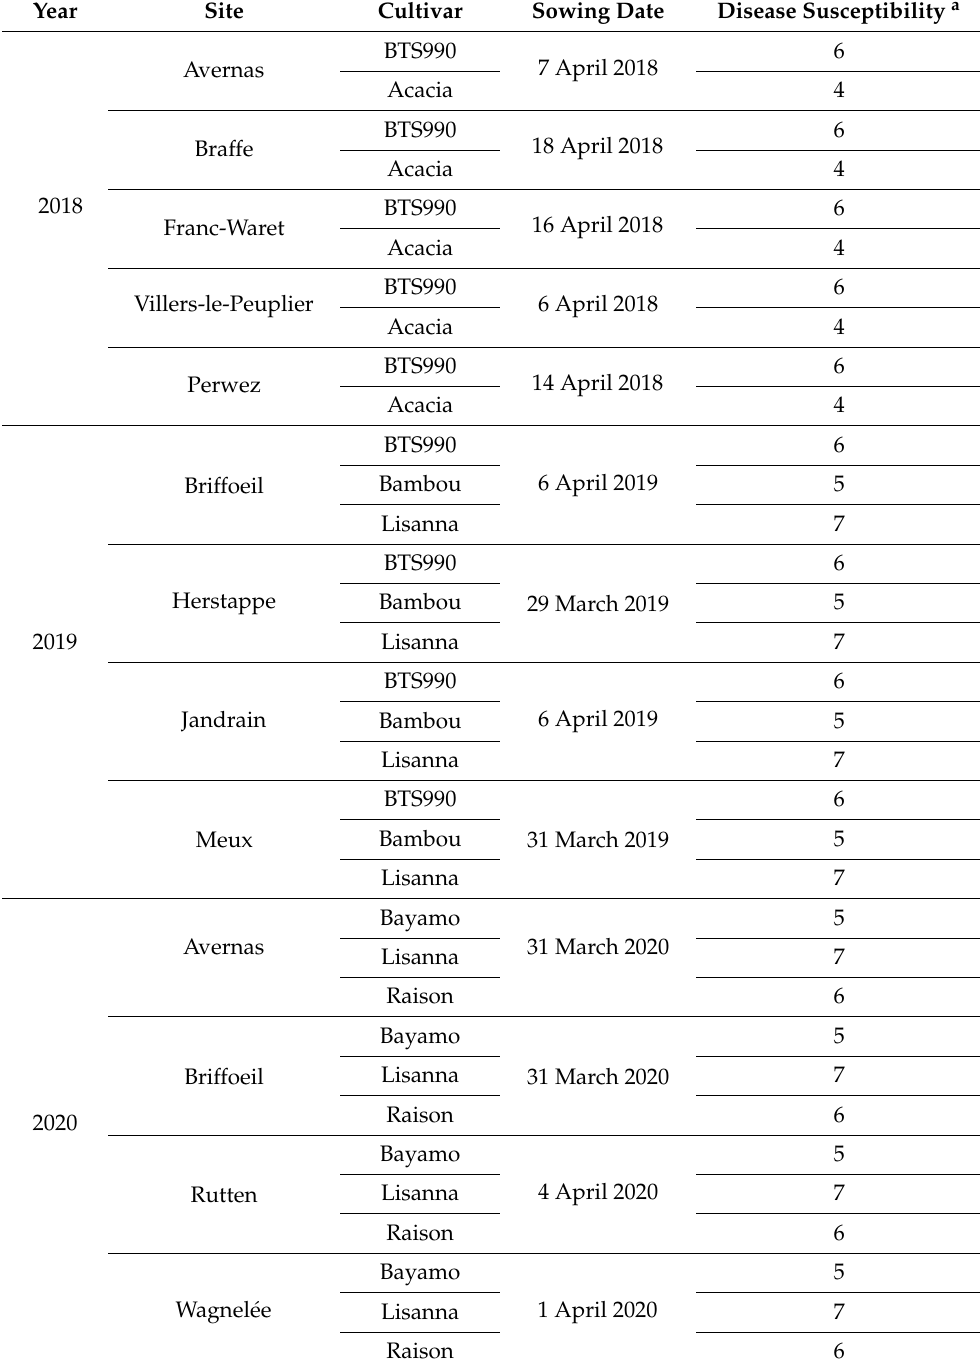
Table 1. Agronomic information for the experimental fields of sugar beet used for assessing Cer- cospora leaf spot in Belgium during the 2018 to 2020 cropping